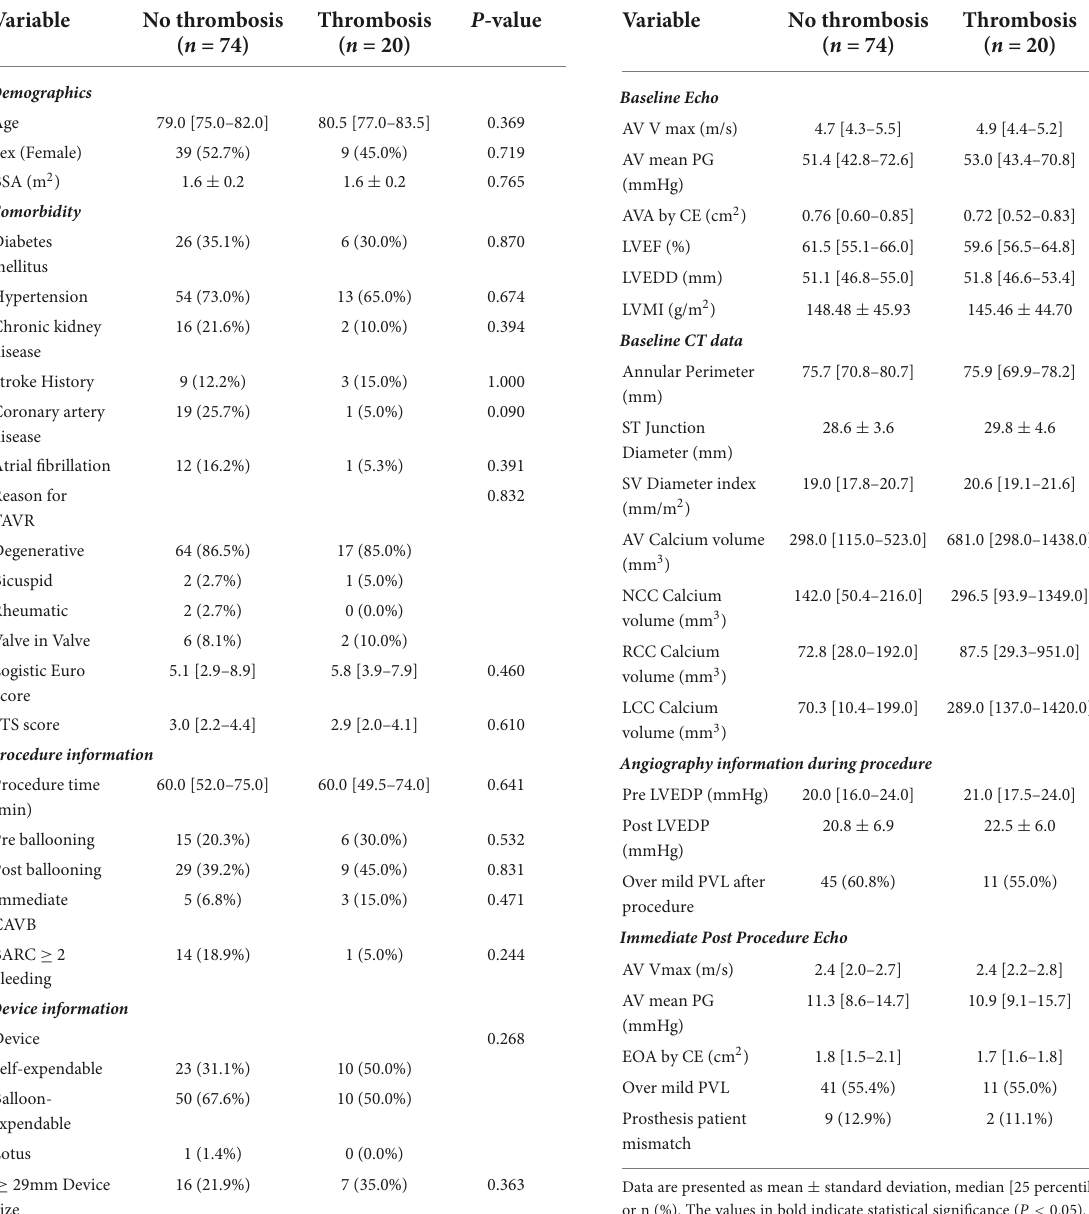
TABLE 1 Baseline characteristics comparison between the no leaflet thrombosis and the leaflet thrombosis group.